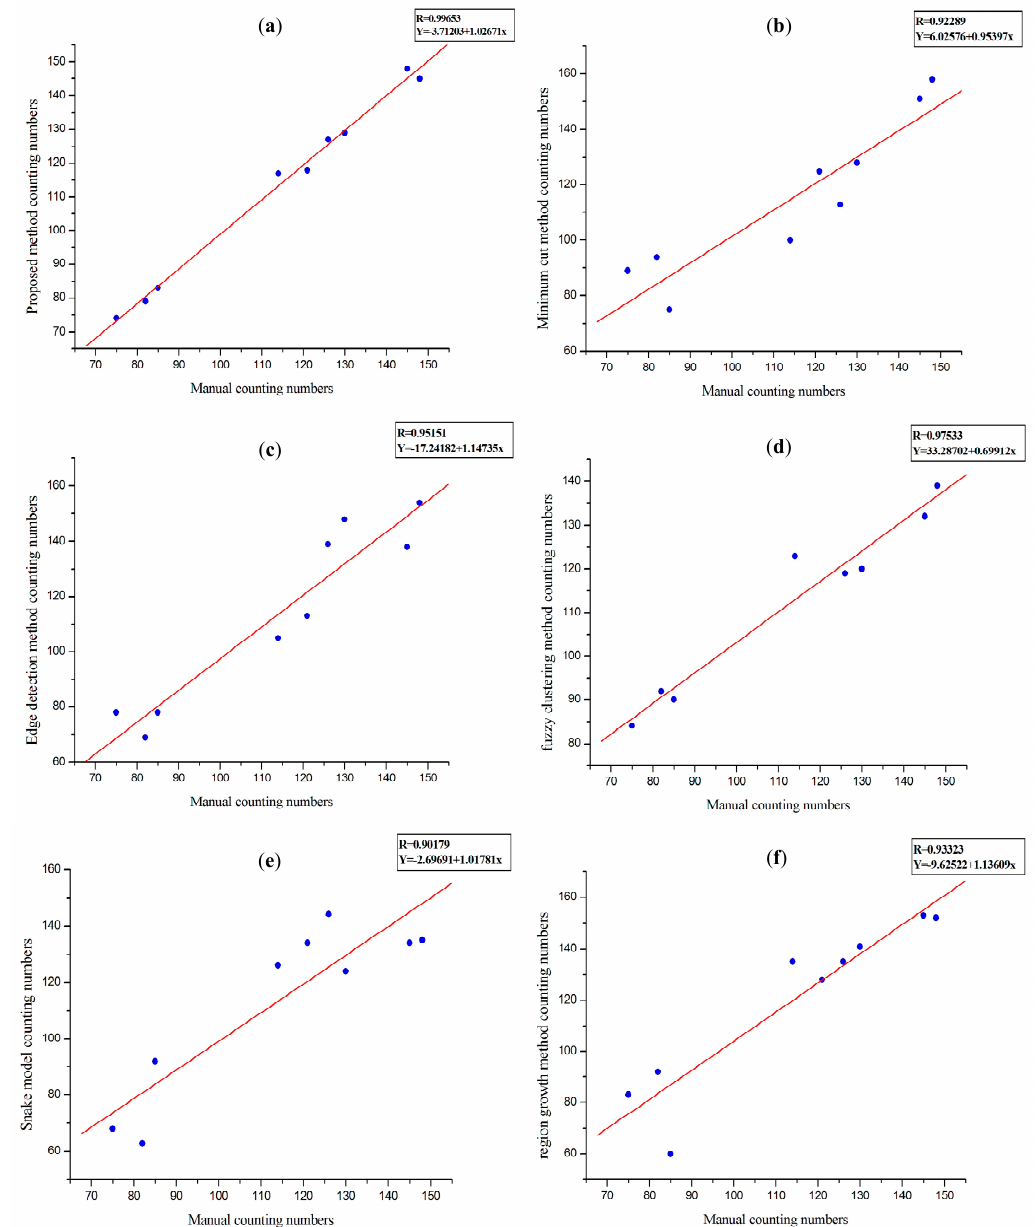
Figure 7. Image segmentation results compared with results of manual measurements.